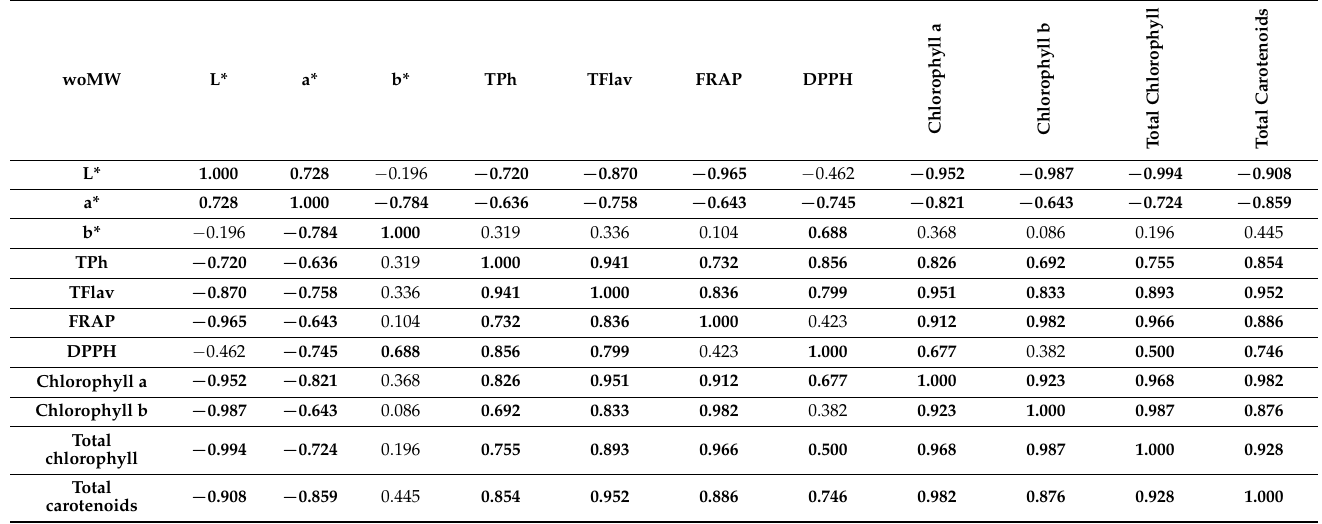
Table 5. Correlations between all parameters of all samples.